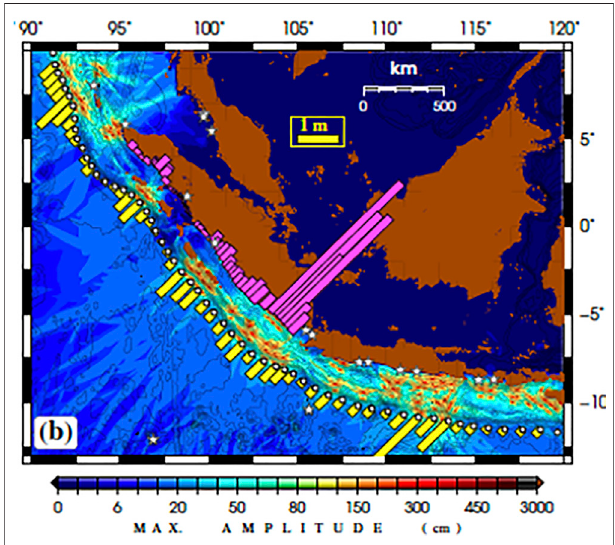
FIGURE 12 | For a possible SMART cable (yellow dots) scenario, tsunami wave heights are calculated from 52 landslide scenarios designed for peak ground acceleration > 0.3 g based on the bottom slope. Yellow bars show predicted tsunami height at each SMART sensor. Pink bars give tsunami height near the shore ( ∼ 60 m water depth). White stars represent existing tide gauges.